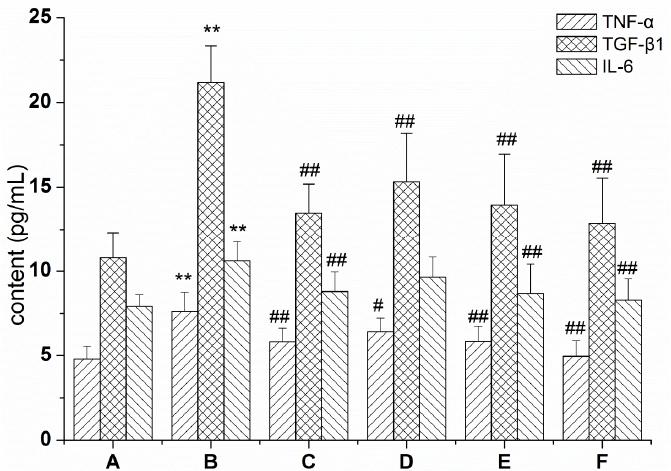
Figure 1. Effects of RRL ( Rhodiola rosea L.) on the levels of transforming growth TNF- α (tumor necrosis factor- α ), TGF- β 1 (transforming growth factor- β 1) and IL-6 (interleukin 6) in the BALF (bronchoalveolar lavage fluid) of BLM (bleomycin)-treated rats. (** p < 0.01 vs. the normal control group; # p < 0.05 vs. the BLM-treated group; ## p < 0.01 vs. the BLM group). (A) normal group; (B) model group; (C) PAG (prednisone acetate) group; (D–F) are RRL group treated with 125, 250 and 500 mg/kg.